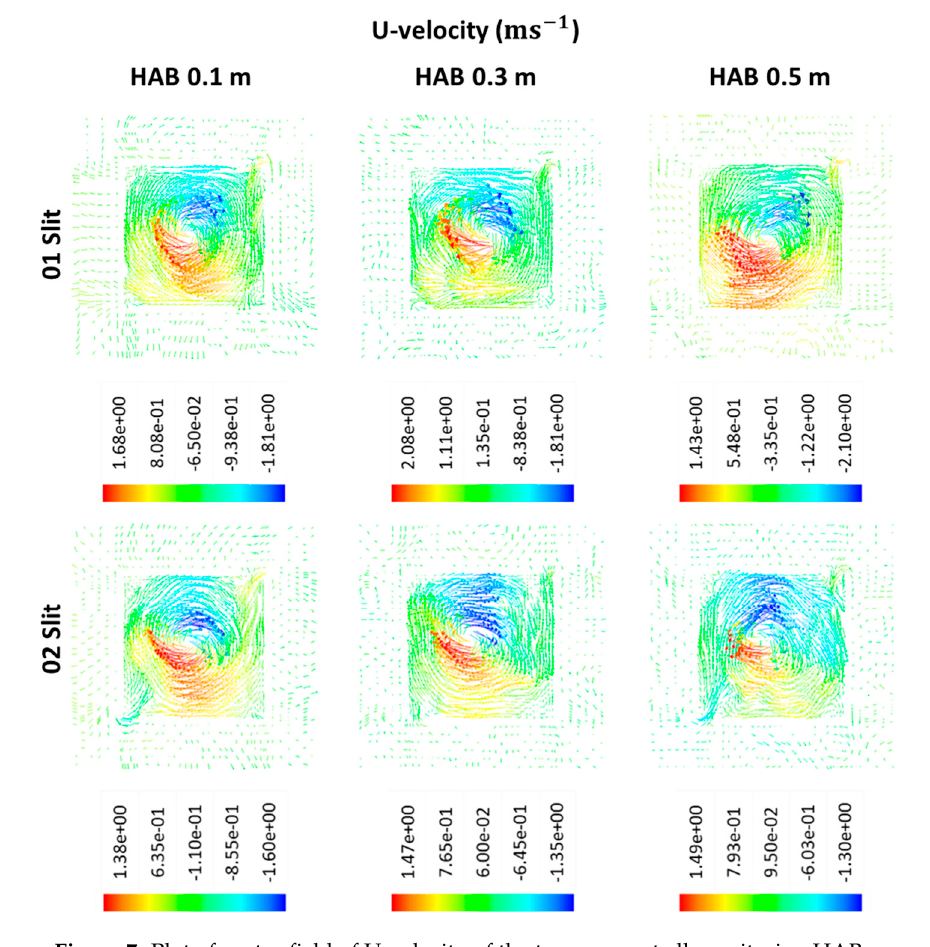
Figure 7. Plot of vector field of U-velocity of the two cases, at all monitoring HABs.